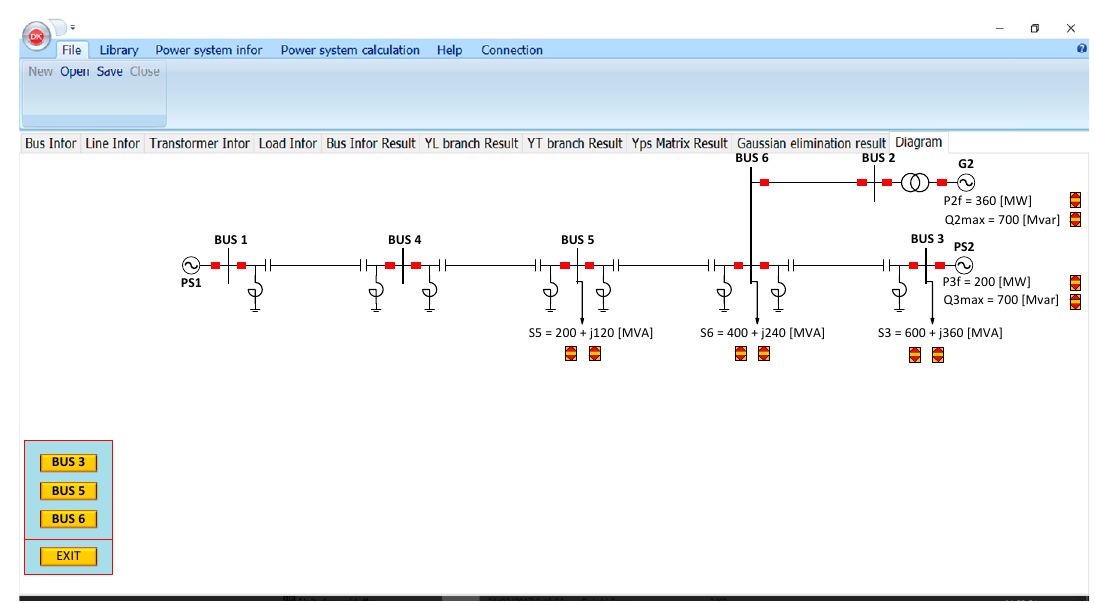
Figure 6. Diagram of the six-bus power system in the program.